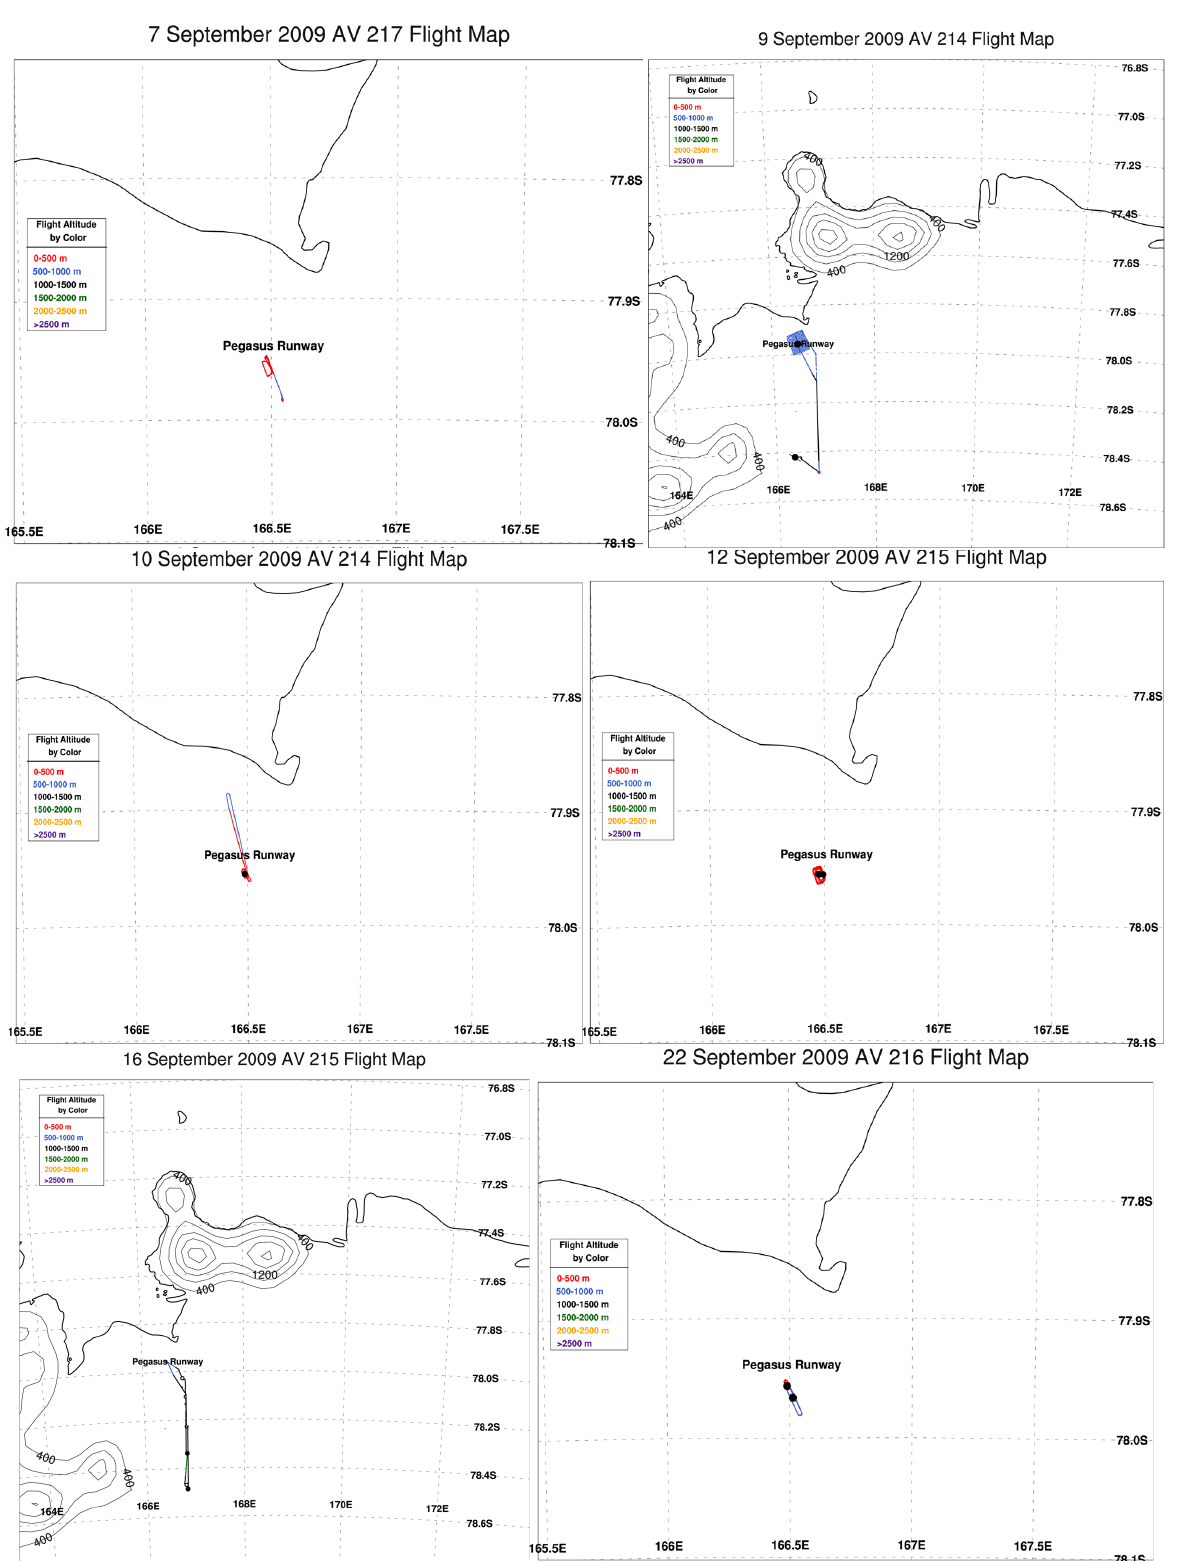
Figure 4. Flight path for the six local flights near Pegasus Runway. Gaps in the flight path indicate a lack of data. Profile locations are marked with a black dot. Flight altitude is indicated by the color scale shown in each panel. Topographical contours are in meters.